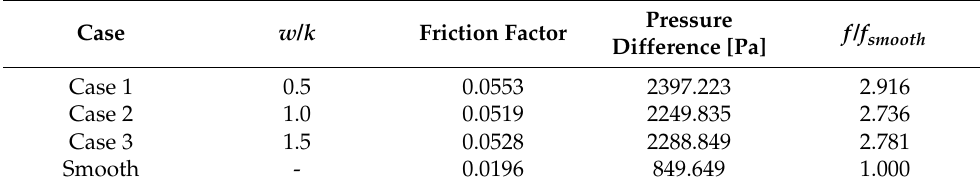
Table 4. Pressure difference and friction factor as a function of w / k with comparison of the value on smooth pipe.